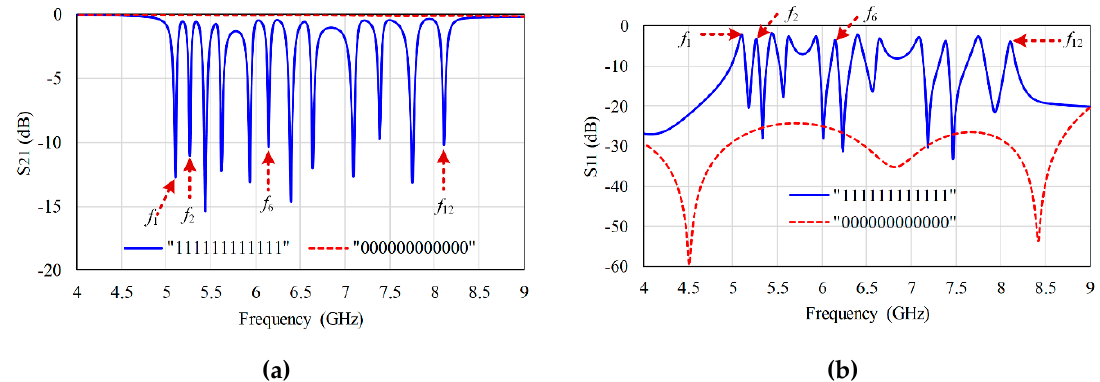
Figure 8. Simulated response of the proposed resonator tag with two different IDs: 111111111111 and